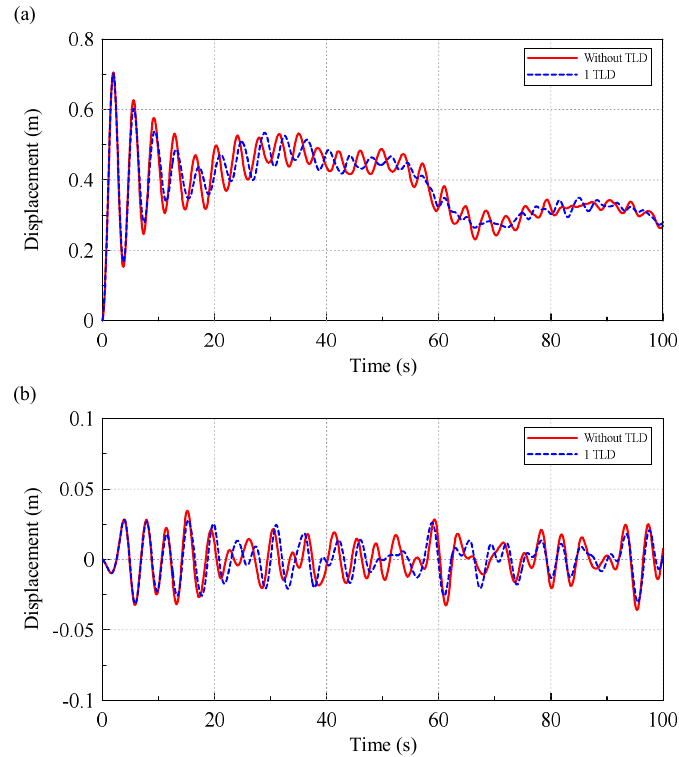
Figure 24. Displacement of RNA for an OWT under the DLC 1.2 condition: ( a ) fore-aft movement; ( b ) side-to-side movement.